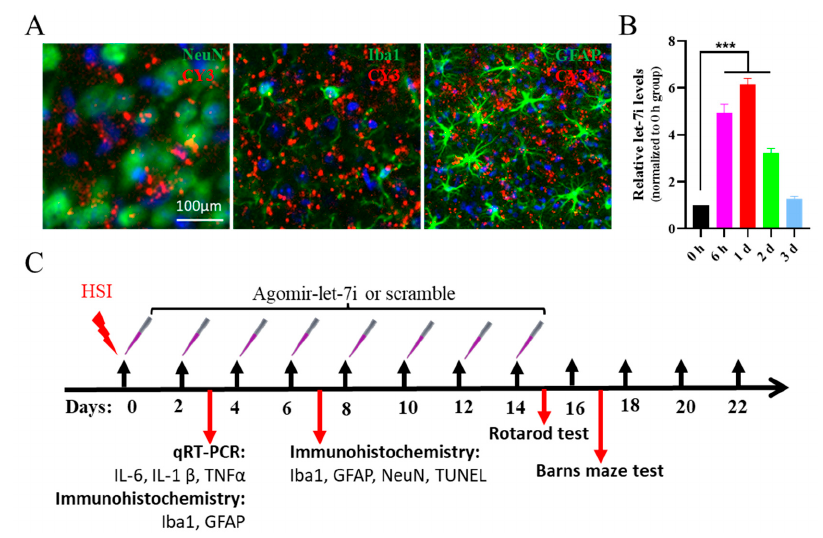
Figure 2. Effective delivery of agomir-let-7i to the cortex via the nasal route and timeline of the HSI experiment. ( A ) Cortex of CY3-labeled agomir-let-7i treatment of C57BL/6 mice at day 1 after nasal drug delivery. Nuclei are stained blue, and CY3-labeled agomir-let-7i displays red fluorescence. ( B ) Expression levels of mature let-7i in the cortex of C57BL/6 mice with a single dose at different time points detected by qRT-PCR analysis. All data are presented as the mean ± SEM. n = 4 mice per group. *** p < 0.001. ( C ) Timeline of the HSI experiment. Two-month-old male mice were assigned to undergo TBI or sham surgery. Agomir-let-7i or scramble was delivered to the brain every other day for a total of 14 days. qPCR analysis of pro-inflammatory mediators (IL-6, IL-1 β , and TNF- α ) and immunohistochemistry of microglia (Iba1 + ) and astrocytes (GFAP + ) were performed at day 3 after HSI (n = 4 mice per group). Neuronal apoptosis (TUNEL + NeuN + ) and glial scar sizes were